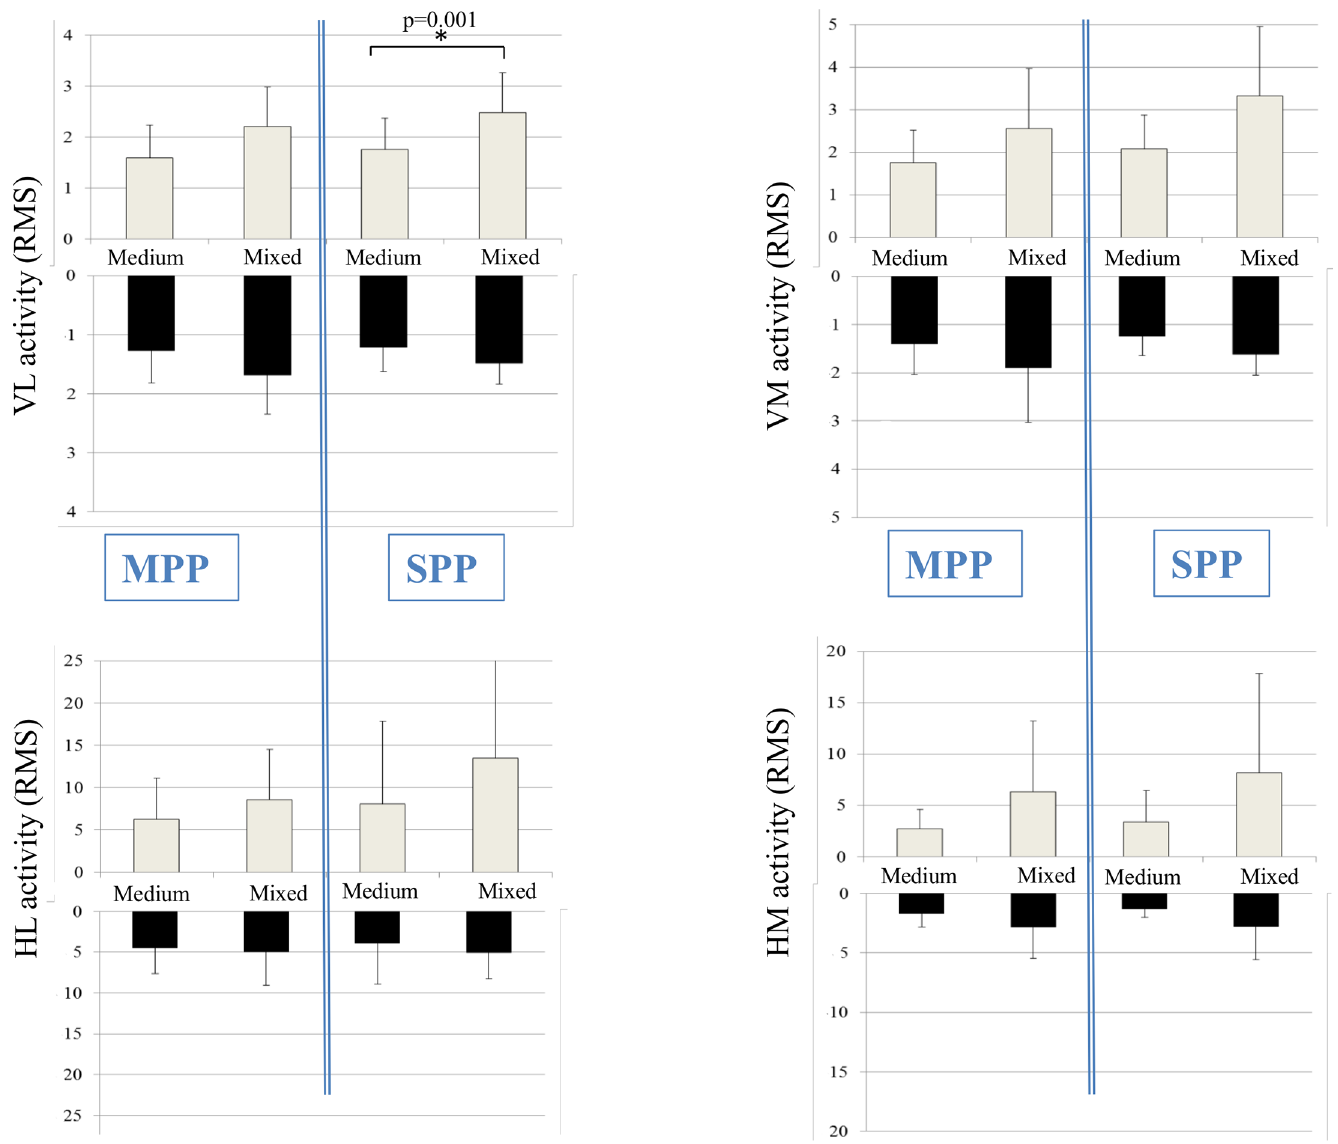
Fig 4. Visualisation of the average muscle activity of the VL, VM, HL and HM in the medium and mixed conditions. The mixed condition consisted of the same amplitude as the medium condition combined with the velocity of the large condition. The light colored bars represent the perturbation phase while the dark colored bars represent the response phase. Post-hoc Bonferroni tests revealed significant differences between conditions and are highlighted with an asterisk (p <